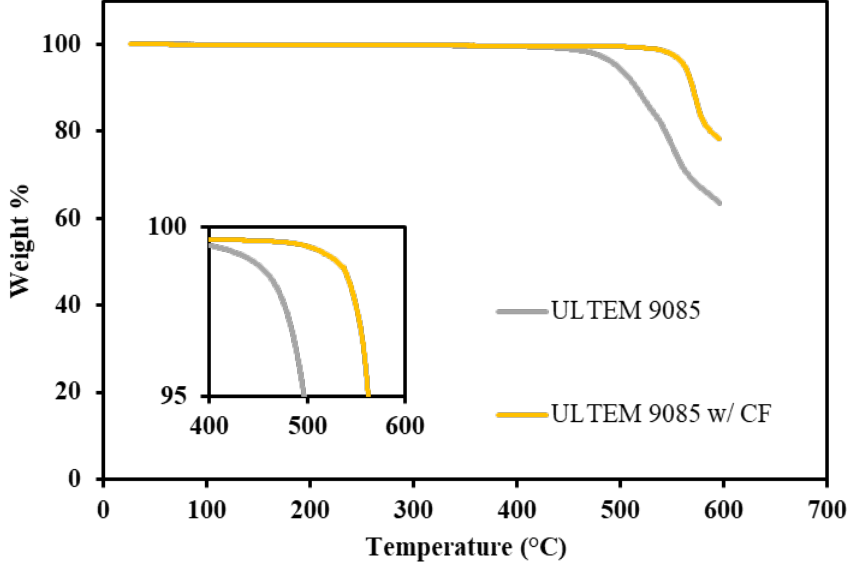
Figure 4. TGA results conducted in air with first 5% of weight loss magnified (inset).